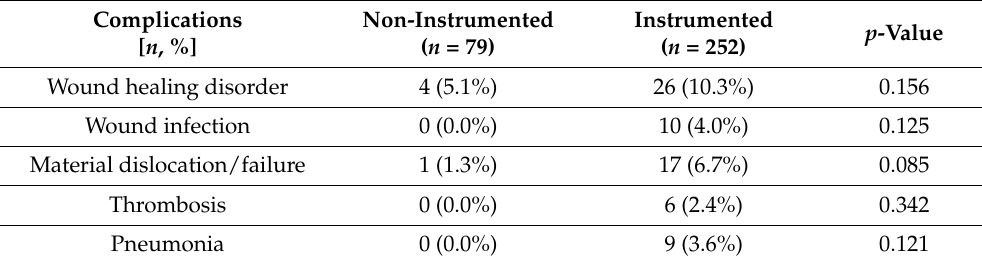
Table 4. Complications.